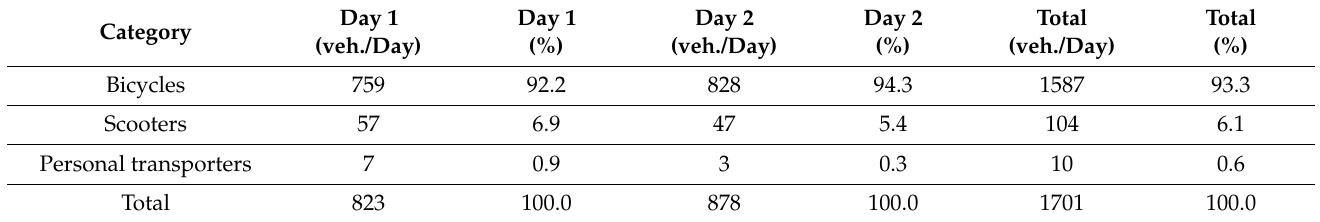
Table 2. Vehicle structure type at the bicycle lane along Stefana Banacha street, broken down by measurement days (own